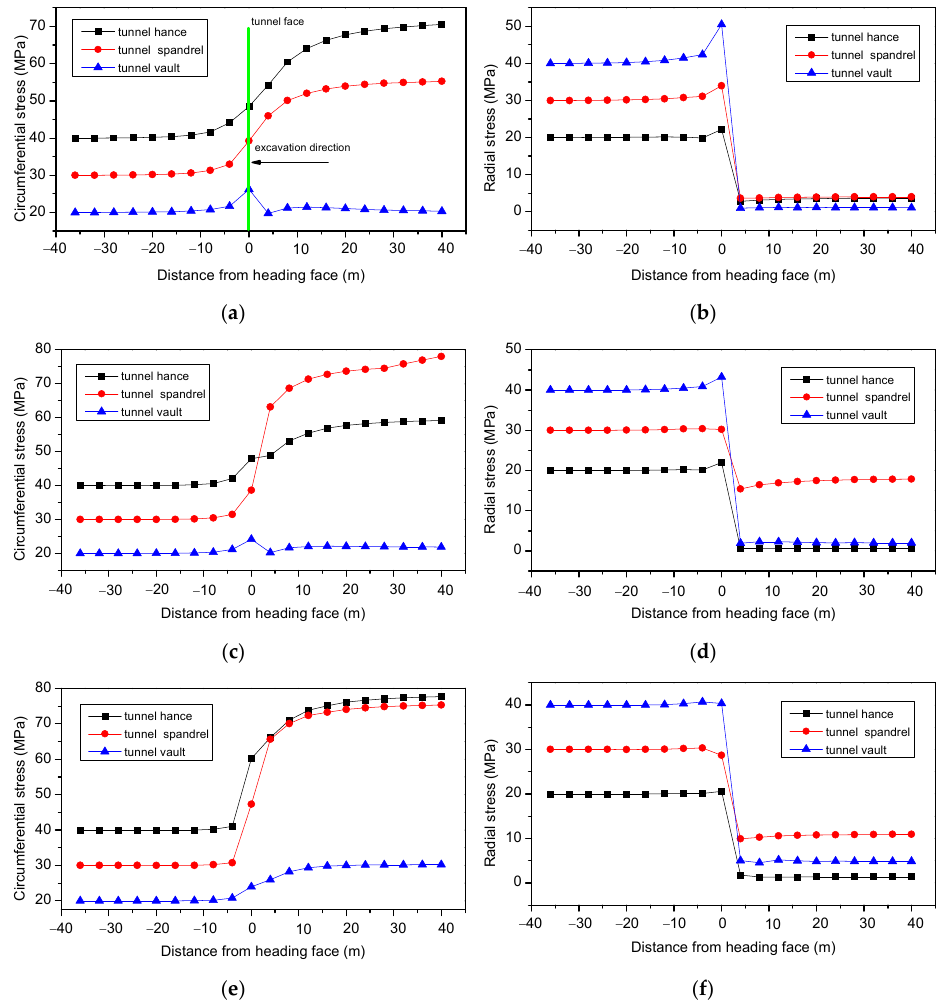
Figure 18. Stress variation of monitoring points after three types of section excavation: ( a ) Circumferential stress of the diversion tunnel; ( b ) Radial stress of the diversion; ( c ) Circumferential stress of the cross passage; ( d ) Radial stress of the cross passage; ( e ) Circumferential stress of the auxiliary tunnel; ( f ) Radial stress of the auxiliary tunnel.